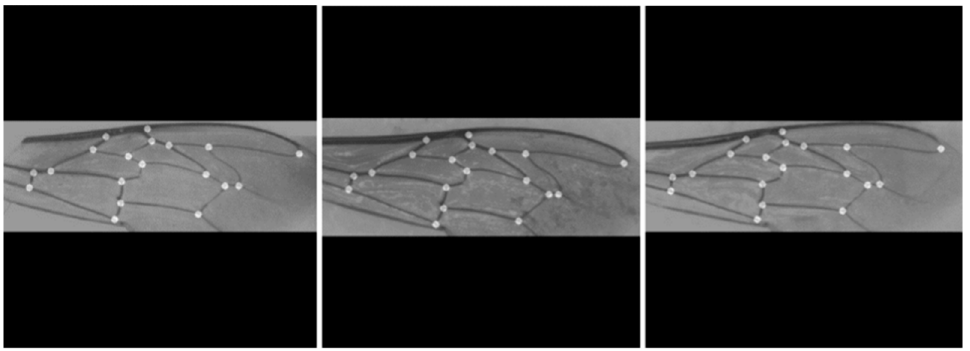
Figure 11. Landmarks superimposed on original wing images.